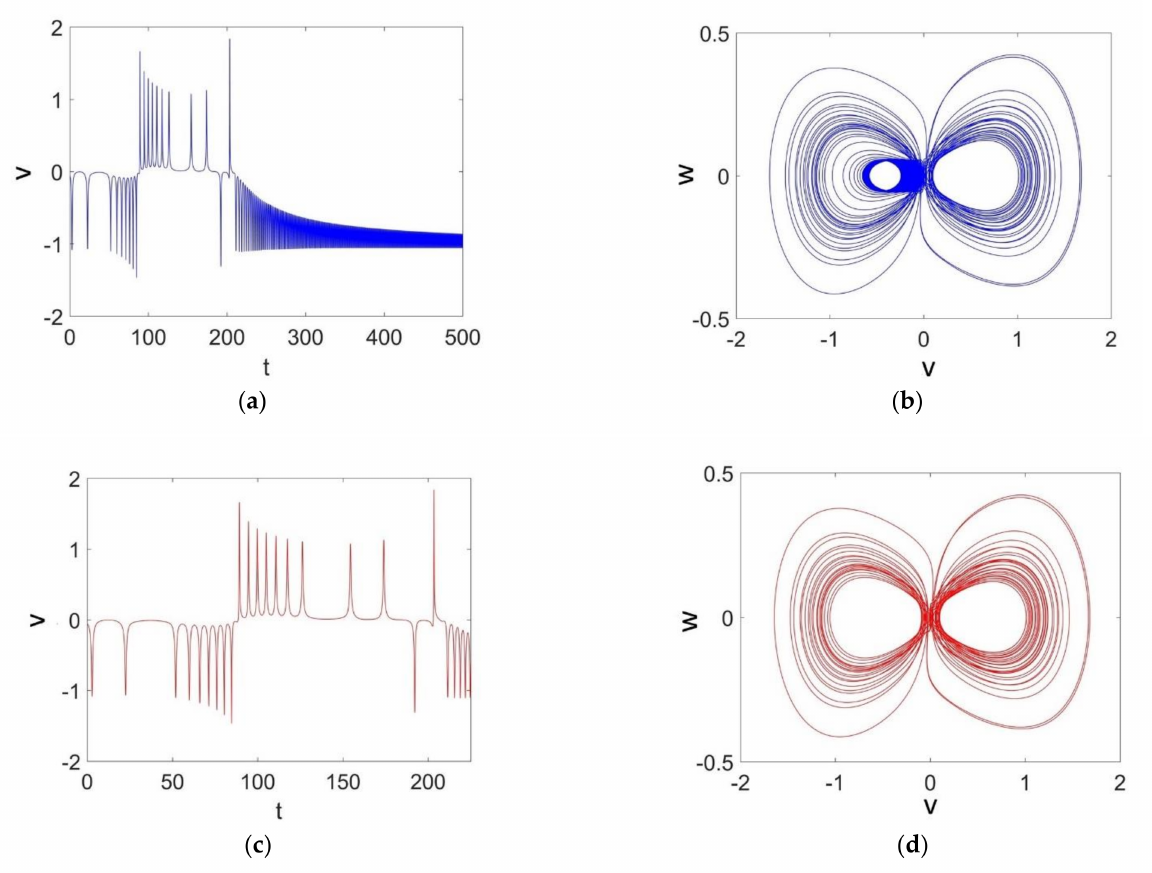
Figure 10. Transient chaos pattern: ( a ) time series of v in the interval [ 0,500 ] s ; ( b ) the phase portrait of the attractor in the ( v , w ) plane; ( c ) time series of v in the interval [ 0,225 ] s ; ( d ) the corresponding phase portrait of the attractor in the ( v , w )